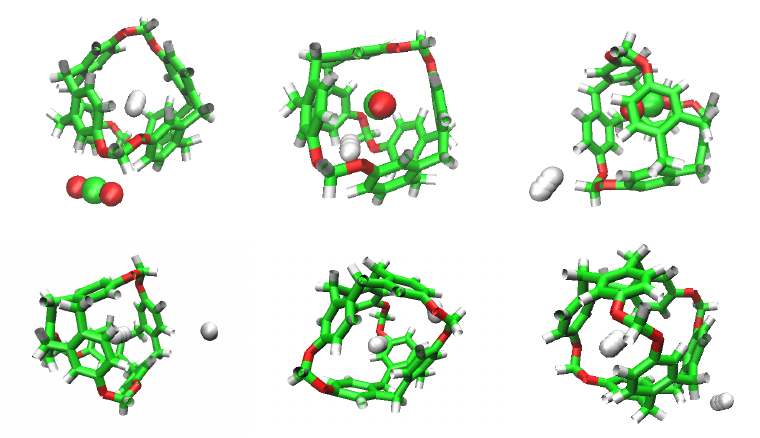
Figure 5. Sequence of H 2 replacement by CO 2 (above) and by another H 2 (below).